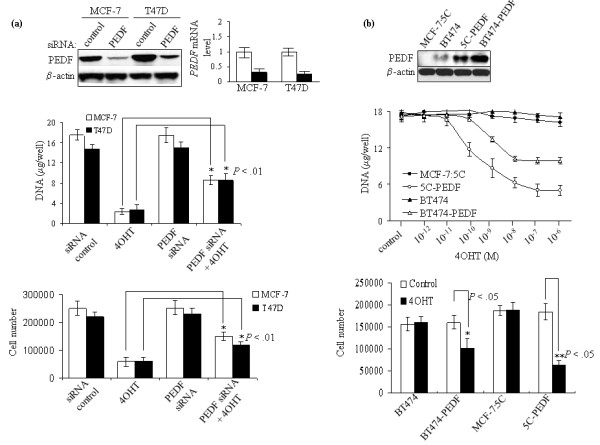
Knockdown of pigment epithelium-derived factor expression by siRNA reduces tamoxifen sensitivity in breast cancer cells. (a) siRNA-mediated reduction of pigment epithelium-derived factor (PEDF) expression in MCF-7 and T47D breast cancer cells was performed as described in Materials and methods. Cells were transfected with PEDF or control siRNA for 72 hours and PEDF protein and mRNA levels were determined by western blot and real-time PCR analyses. Transfected cells were also treated with 1 μM 4-hydroxytamoxifen (4OHT) for 72 hours and cell proliferation was determined by DNA quantitation assay and by cell counting using trypan blue exclusion. All experimental points are given as the average of triplicates. (b) Stable expression of PEDF in endocrine-resistant MCF-7:5C and BT474 breast cancer cells sensitized them to tamoxifen. A lentiviral construct encoding the human PEDF cDNA was used to stably express PEDF in MCF-7:5C and BT474 cells. Western blot analysis was used to confirm stable expression of PEDF protein in MCF-7:5C and BT474 cells (top panel). To determine the effect of PEDF expression on tamoxifen sensitivity, lentiviral transduced 5C-PEDF and BT474-PEDF cells were treated with 10-12 M to 10-6 M 4OHT for 72 hours and cell proliferation was determined by DNA quantitation assay (middle panel) and by cell counting using trypan blue exclusion (bottom panel). All experimental points are given as the average of triplicates. Assays were performed twice.